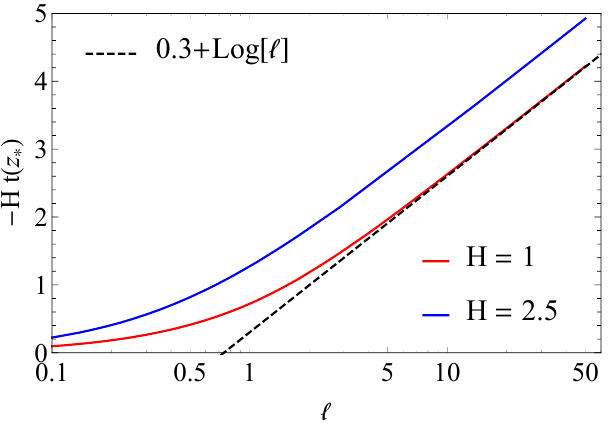
Figure 13 . Minimum time reached on the extremal surface (see also figure 10) as a function of length. At large ‘ this time grows logarithmically with ‘